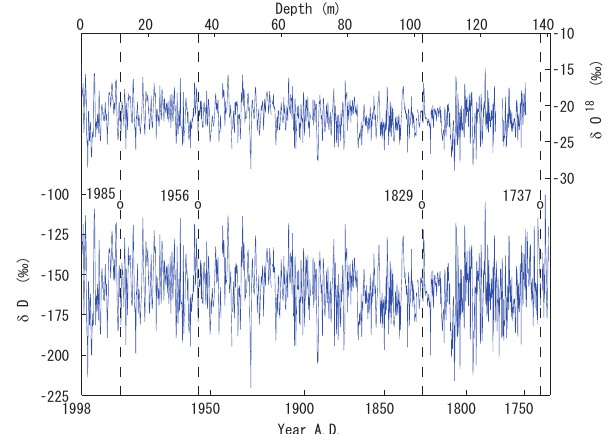
Fig. 5. Thinning rates calculated by the Salamatin (dotted line) and Elmer/Ice (solid line) models.